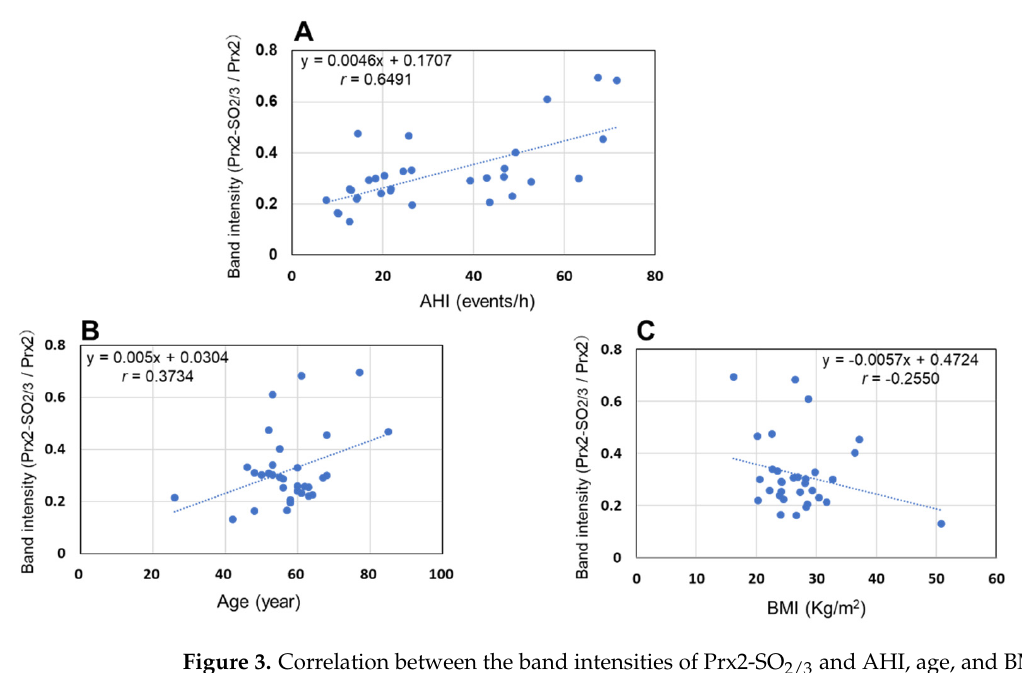
Figure 3. Correlation between the band intensities of Prx2-SO 2/3 and AHI, age, and BMI correspond- ing to each patient with OSA. The band intensity of patients with OSA ( n = 32) was expressed as the normalized ratio of density (Prx2-SO 2/3 /Prx2). AHI was measured using a polysomnography test. BMI was calculated using a person’s height and weight (kg/m 2 ). ( A ): correlation between band intensity and AHI; ( B ): correlation between band intensity and age; ( C ): correlation between band intensity and BMI.